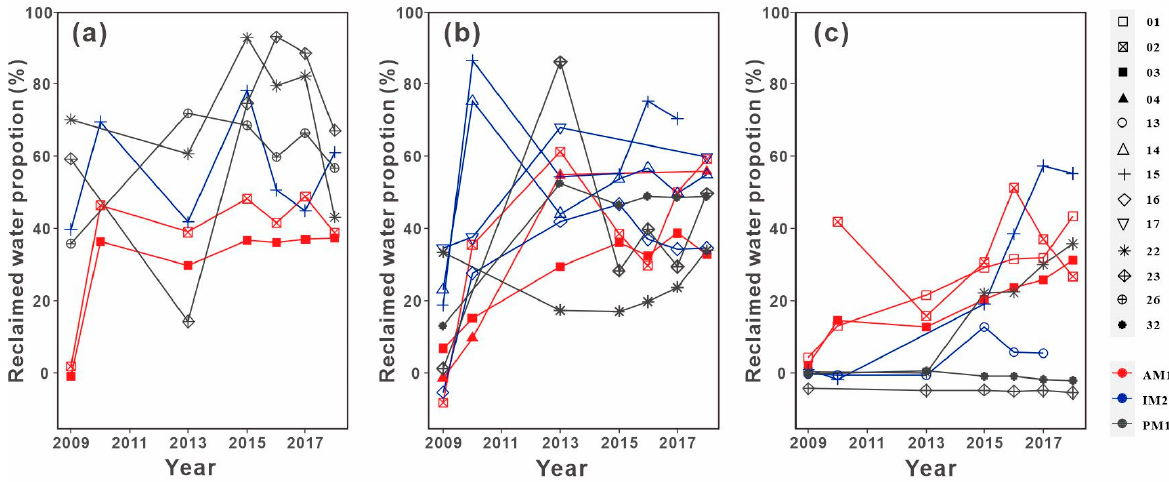
Figure 9. Proportion of reclaimed water in ( a ) the 30-m depth groundwater, ( b ) the 50-m depth groundwater, and ( c ) the 80-m depth groundwater of different year, based on the Cl − concentrations. AM1: Anti-seepage reach monitoring cross-section 1; IM2: Intermittent intake reach monitoring cross-section 2; PM1: Perennial intake reach monitoring cross-section 1.